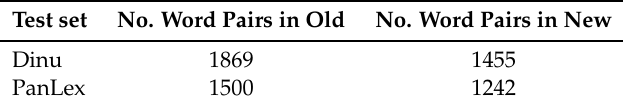
Table 8. Word reduction of the new test sets.